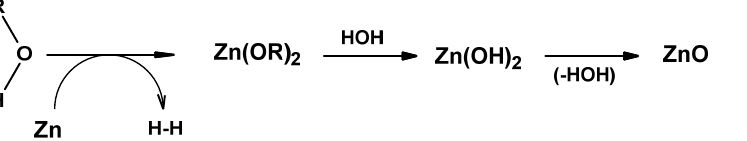
Figure 3. Putative mechanism of the reaction of zinc with alcohols (R = Me or Et) [119–122].